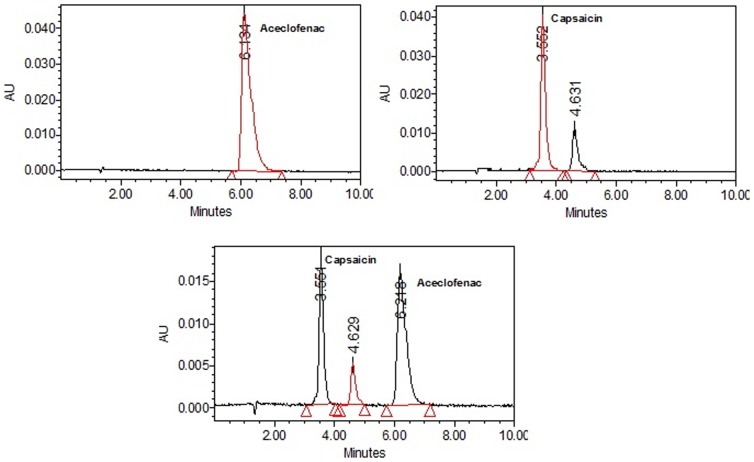
Chromatograms showing separation of aceclofenac and capsaicin.Mobile Phase: Acetonitrile+10 mM acetate buffer (55+45 v/v) pH adjusted to 3 with acetic acid. Flow: 1 mL/min. Column: Symmetry C18 column, 150×4.5 mm.